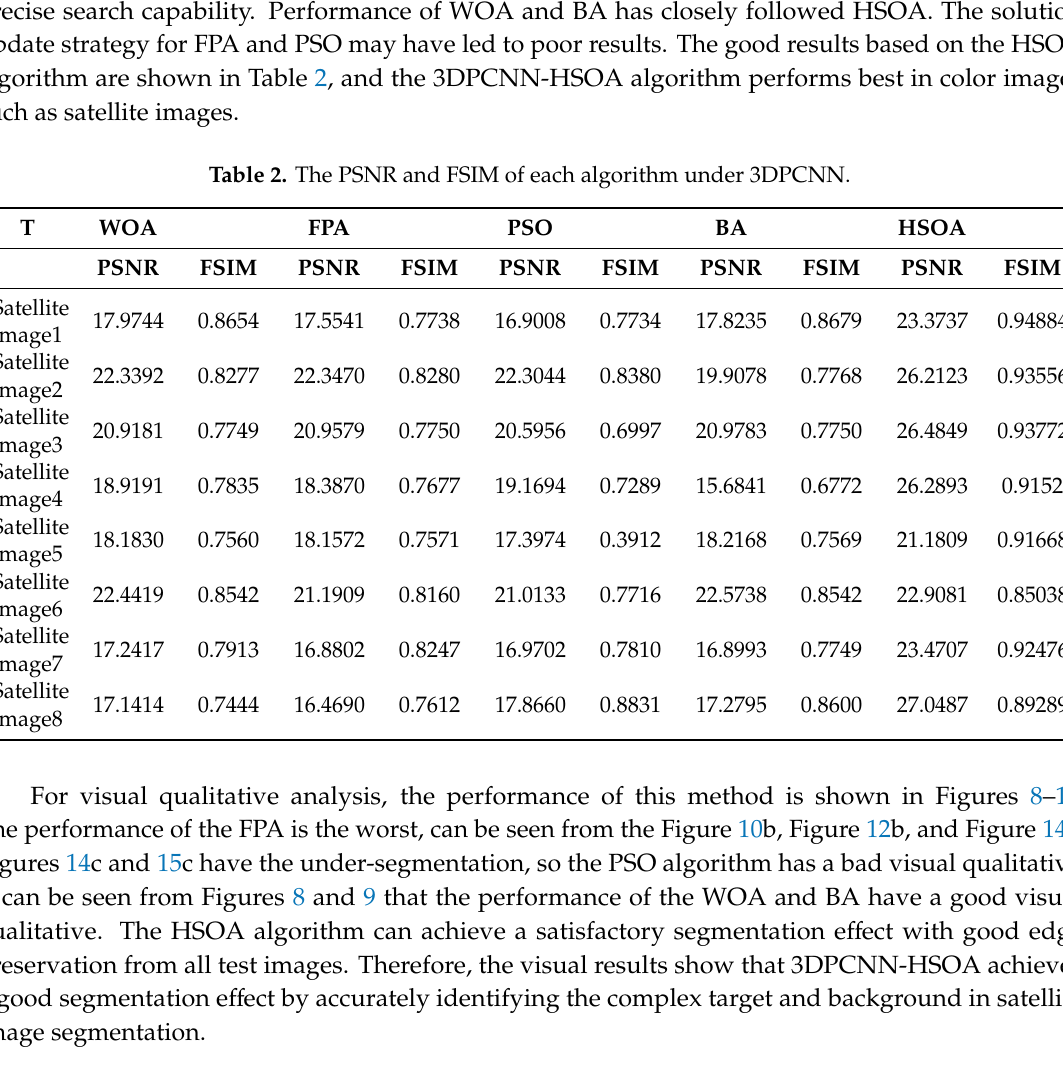
(e) Figure 9. The segmented results of Satellite image2. ( a ) WOA; ( b ) FPA; ( c ) PSO; ( d ) BA; and ( e ) HSOA. (a)